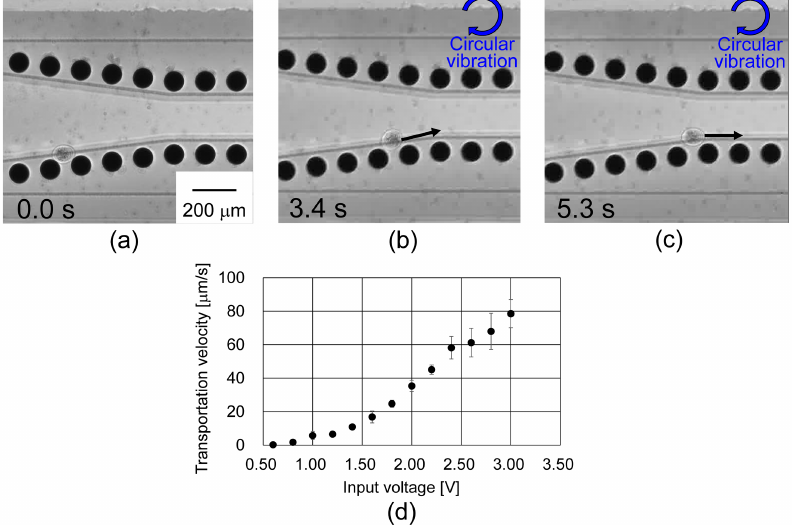
Figure 9. Demonstration of oocyte transportation under a vibration-induced flow, and the experimental result: Microscopic images ( a ) before application of the circular vibration; ( b ) after 3.4 s; ( c ) after 5.3 s; ( d ) transportation velocity vs. input